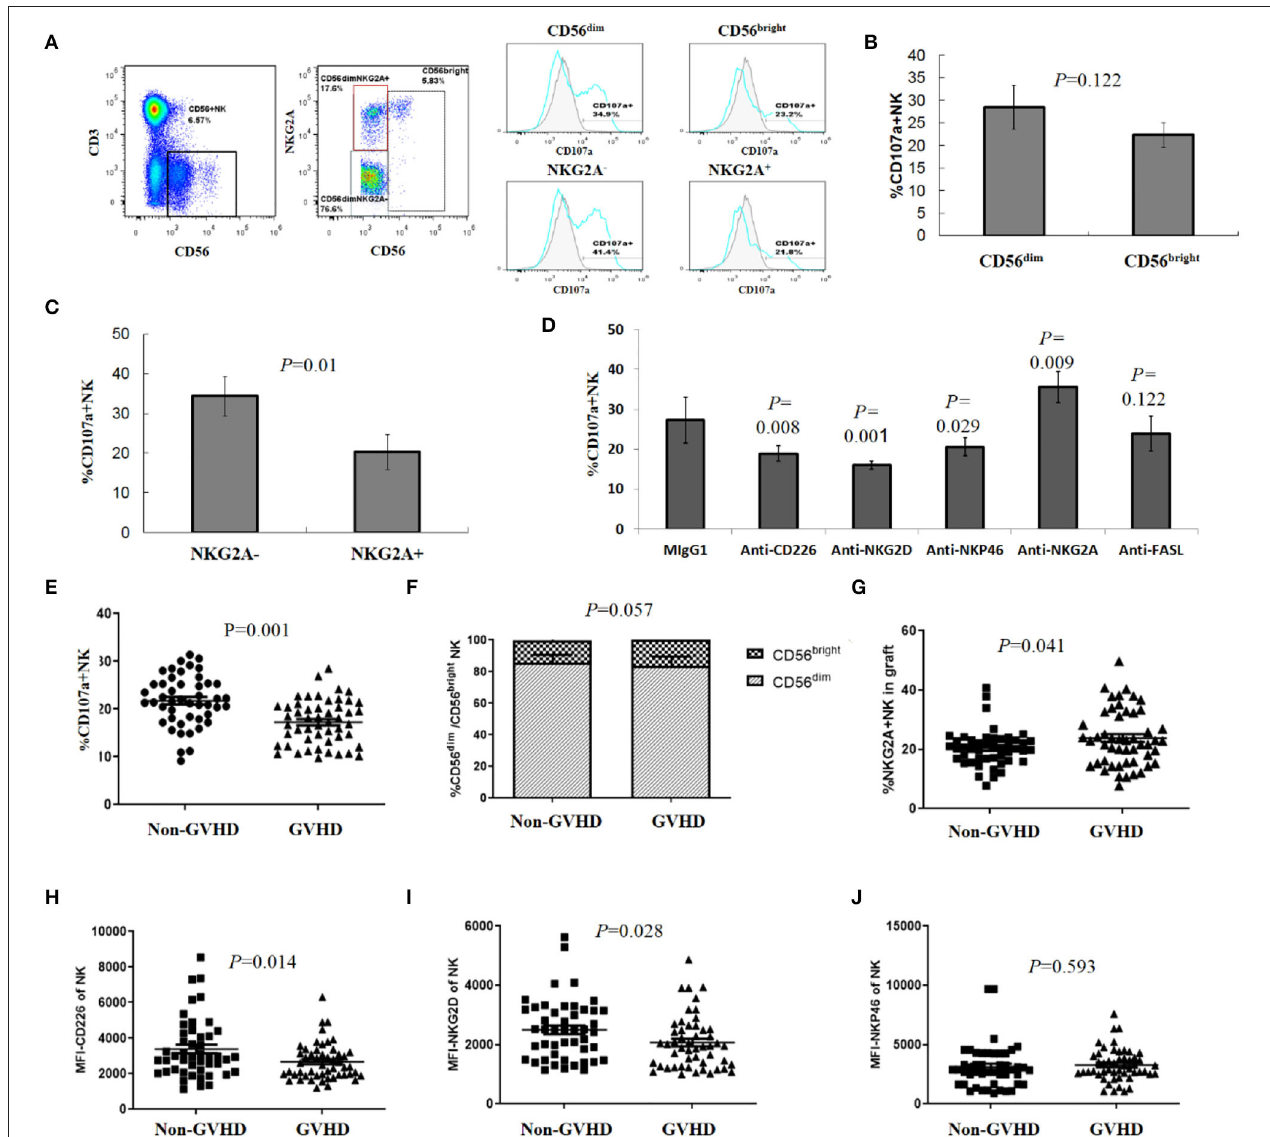
FIGURE 2 | Subgroup and receptor expression of donor NK cells affected NK degranulation toward activated T cells associated with aGVHD. (A) Representative gating strategy. CD56 dim and CD56 bright NK cells were gated and subsets were defined based on the expression of NKG2A, the percentage of CD107a positive cells was analyzed on each subset of NK cells. (B) CD107a expression in CD56 dim and CD56 bright NK cells ( n = 4), (C) CD107a expression in NKG2A − and NKG2A + subgroups ( n = 4), (D) NK cells were pretreated with neutralizing antibodies (or relevant isotype-matched Ig controls) before degranulation assay ( n = 4). (E) Levels of donor NK degranulation toward activated T cells were significantly lower in the aGVHD group than in the non-aGVHD group ( P = 0.001, n = 98). Percentage of CD56 dim and CD56 bright NK cells (F) , NKG2A + NK cells (G) in allografts from the aGVHD and non-aGVHD groups ( n = 98). MFI of CD226 (H) ; NKG2D (I) and NKP46 (J) of NK cells in allografts from aGVHD and non-aGVHD groups ( n = 98). All calculated averages were defined as the parametric mean ± SD. Student’s t -tests or two-way ANOVA analyses were used to compare the mean among groups.